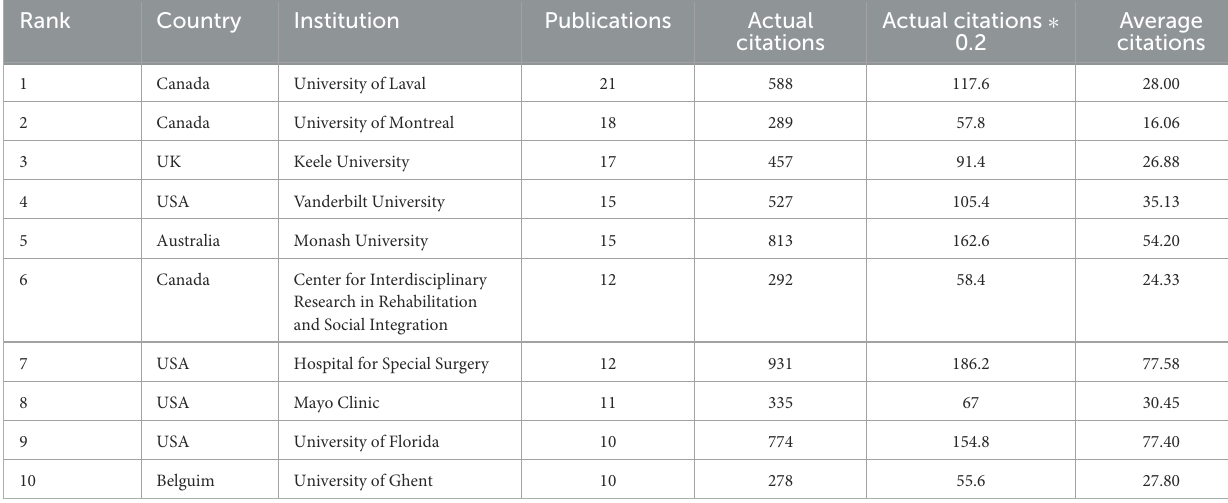
TABLE 2 Top 10 contributive institutions with publications on the rehabilitation of RCI.